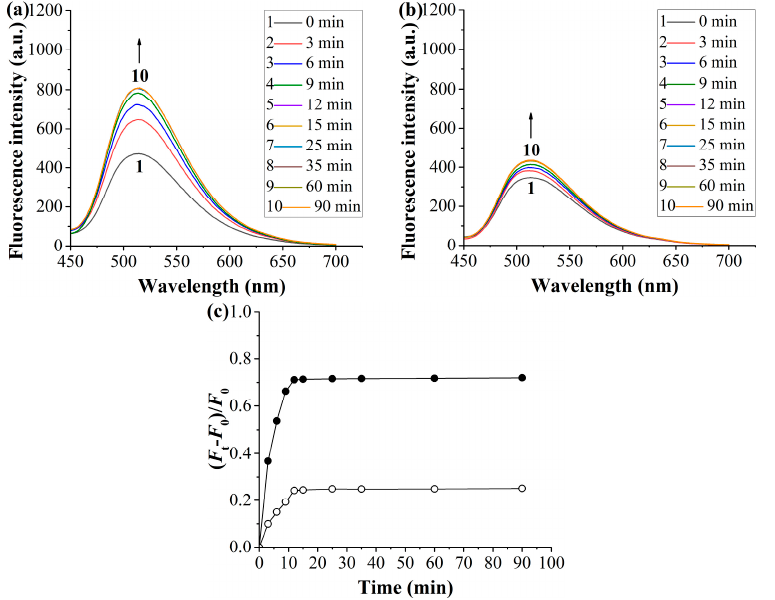
Figure 3. ( a , b ) Fluorescence spectra of the hydrophilic fluorescent hollow HA-MIP ( a )/CP ( b ) after their incubation with a HA solution (20 μ M) in the artificial urine at 25 °C for different times (hollow MIP/CP concentration: 0.25 mg/mL; their concentration was calculated by using the weight of their corresponding solid ones before etching). ( c ) Optosensing kinetics of the hydrophilic fluorescent hollow HA-MIP (filled symbol)/CP (open symbol) in a HA solution (20 μ M) in the artificial urine at 25 °C (derived from Figure 3( a , b ); F t and F 0 in ( F t − F 0 )/ F 0 are the fluorescence intensity of the NBD unit (at 514 nm) at a time of t and 0, respectively).